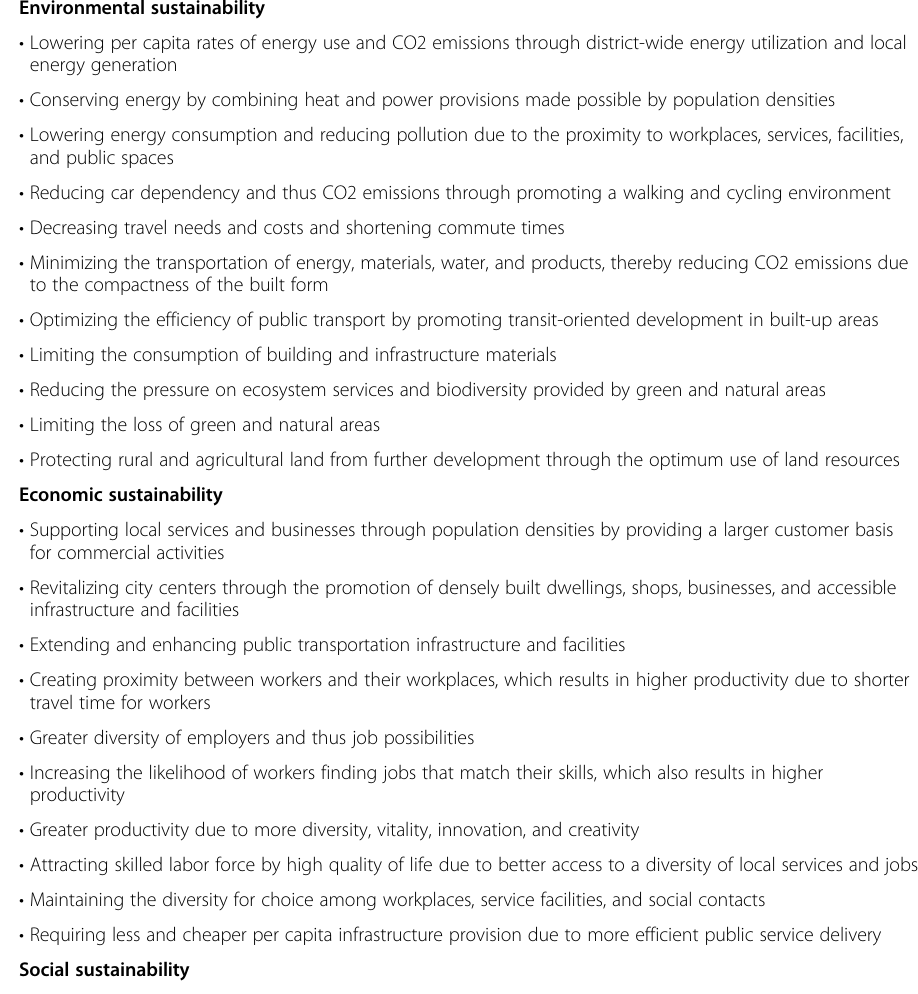
Table 5 The contribution of the compact city to the three goals of sustainability Environmental